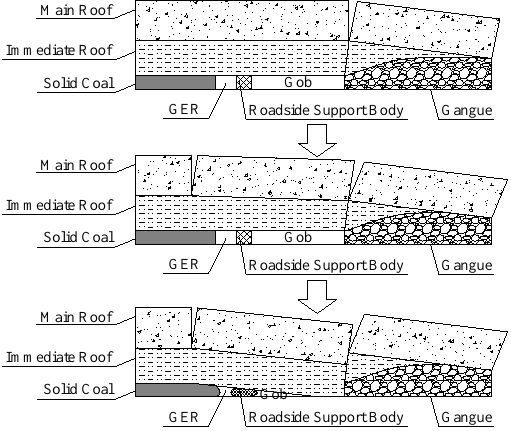
Figure 3. The evolution of large pressure in the hard roof strata. GER: gob-side entry retaining.